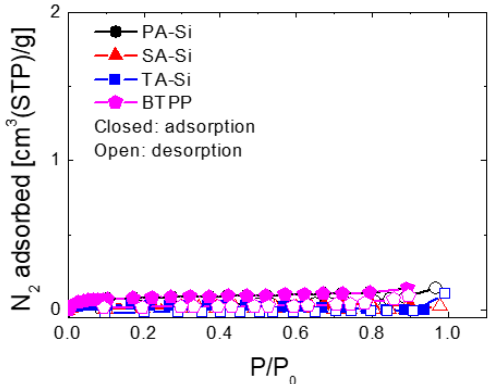
Figure 6. N 2 adsorption/desorption isotherms of several amine-functionalized organosilica materials fired at a “safe” temperature (300 °C for BTPP and 250 °C for PA-Si, SA-Si, and TA-Si) under a N 2 atmosphere. These results were reorganized from refs. [21,22].